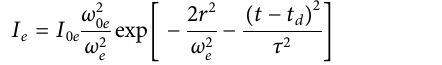
Frontiers in Materials |